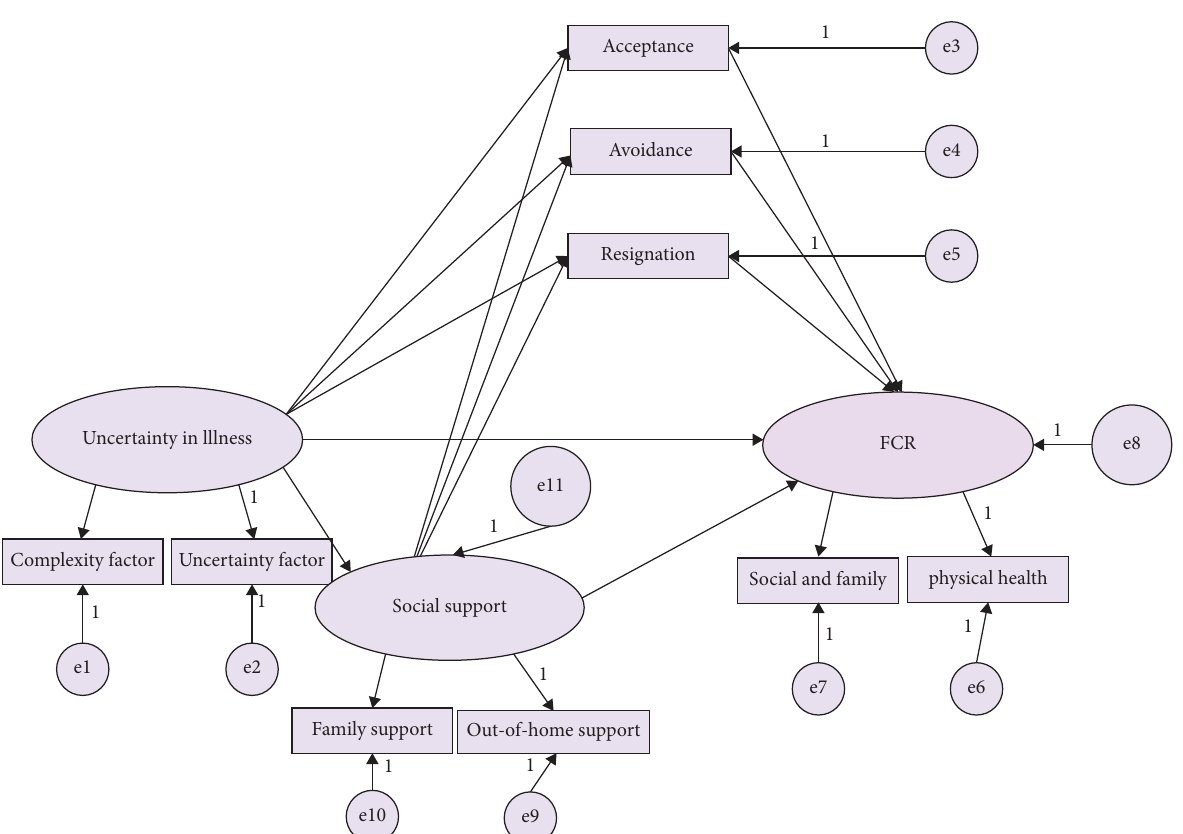
Figure 1: Assumption diagram of structural equation model of infuencing factors for FCR in breast cancer